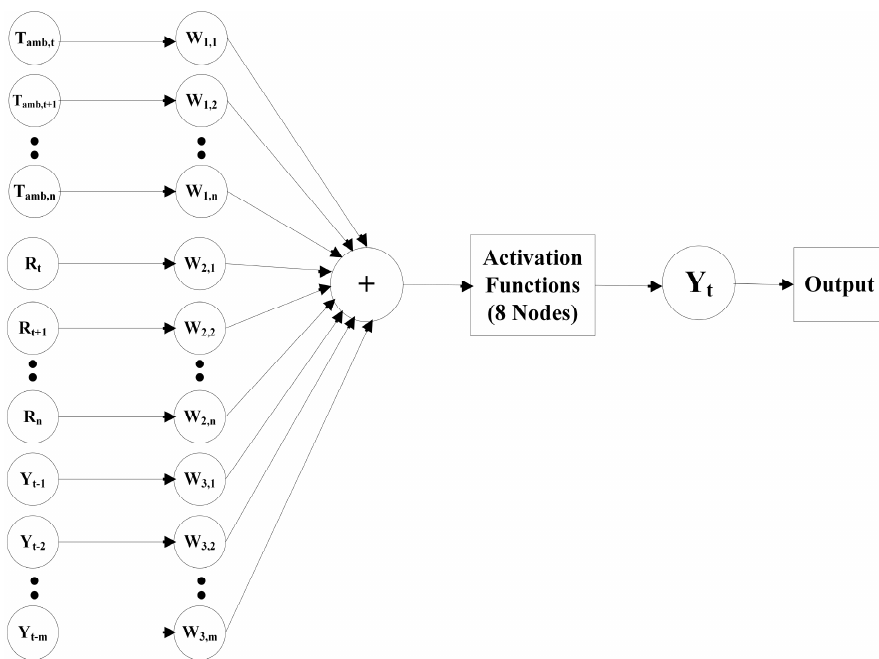
Figure 10. A diagram for base case N ‐ ARXnet structure for predicting energy demand.